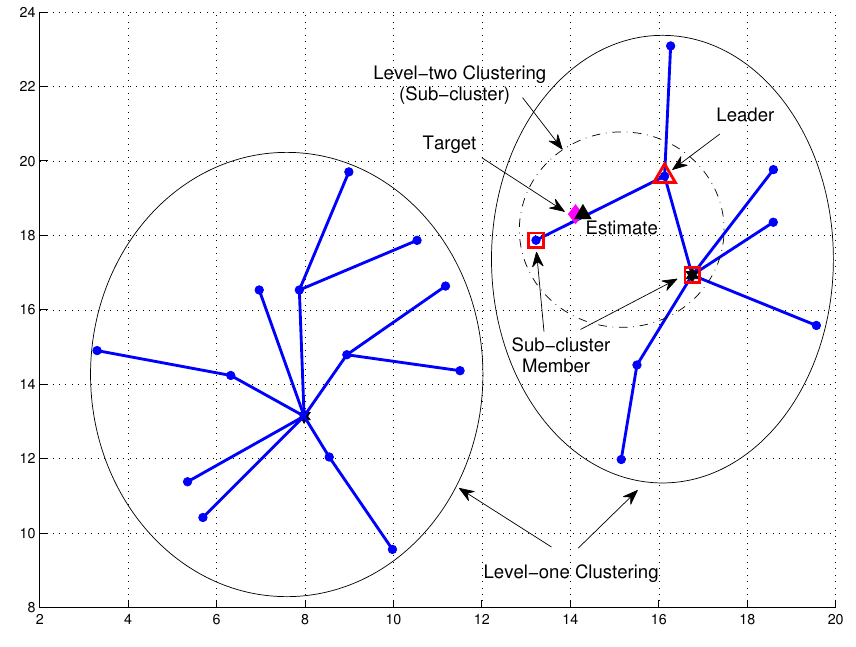
Figure 4. An example of Level 2 clustering for the tracking